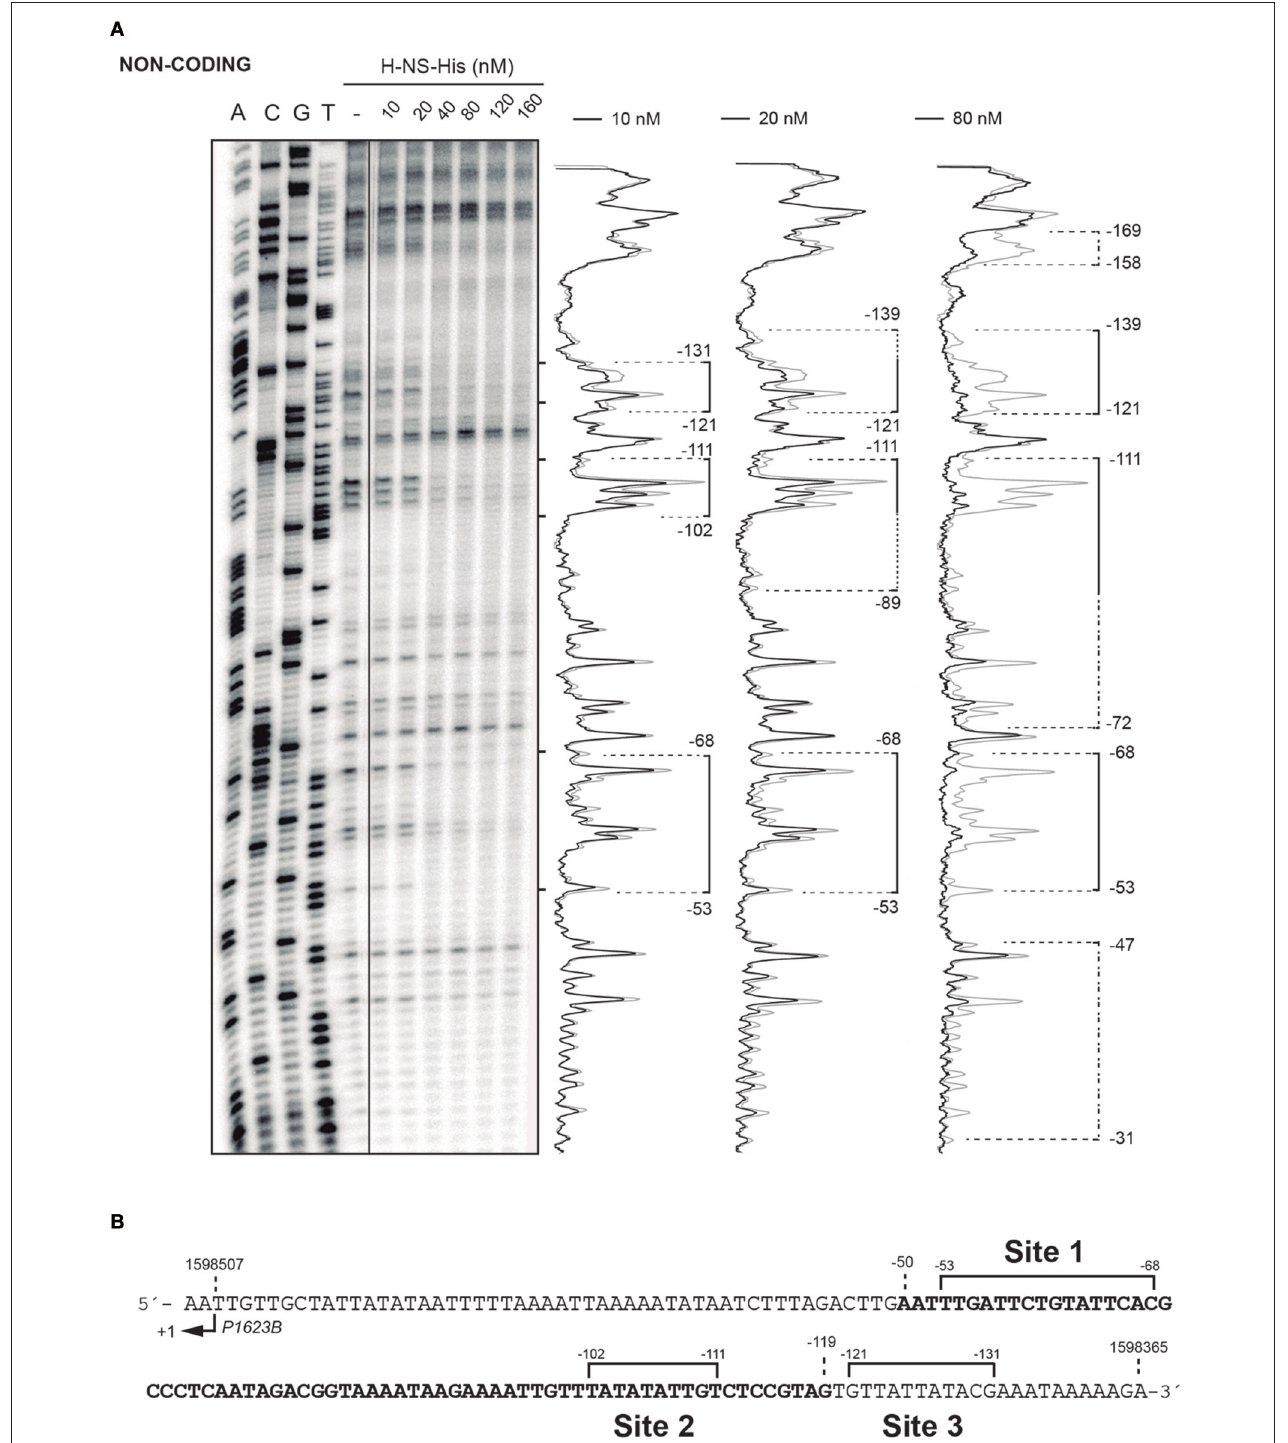
FIGURE 7 | DNase I footprints of complexes formed by H-NS-His on the 222-bp DNA fragment. (A) The 222-bp DNA fragment of the R6 chromosome (coordinates 1598298–1598519) was radioactively labeled at the 5 ′ -end of the non-coding strand. Labeled DNA (2nM) was incubated with increasing concentrations of H-NS-His and then digested with DNase I. Dideoxy-mediated chain-termination sequencing reactions were run in the same gel (lanes A, C, G, T). Densitometer scans corresponding to free DNA (gray line) and DNA with protein (black line; 10, 20, and 80nM) are shown. Brackets indicate H-NS-His binding sites. Extension